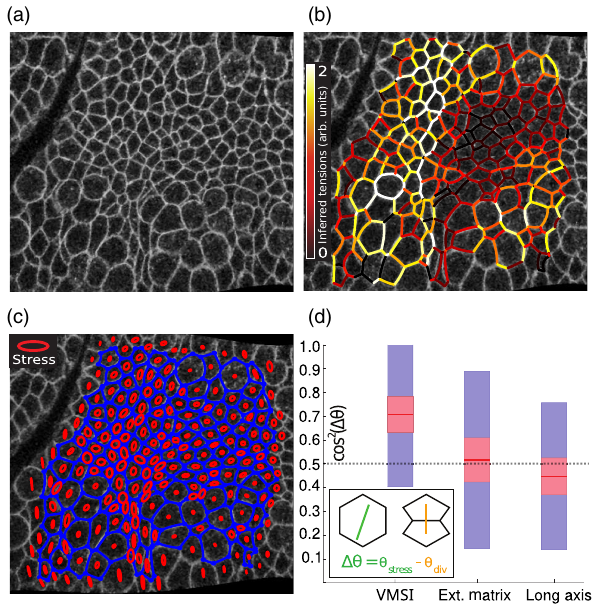
FIG. 6. Correlation of inferred stress and cell-division axis. (a) Confocal image of the Drosophila lateral ectoderm, near the cephalic furrow, during the late phase of germ-band extension (GBE) at the onset of cell divisions, approximately 45 min after the formation of the cephalic furrow. (b) An overlay of inferred tensions on the CAP array. Note that a low-tension edge (dark red) meets two high-tension edges; the latter meet at an angle close to π while low-tension edge is nearly perpendicular. (c) Same as (b) but with the average stress tensor for each cell plotted as an ellipse. The major or minor axis of the ellipse corresponds to the principal axes of stress. (d) Comparison of the cell cleavage axis for cell division events (within mitotic domains 6 and 11 [49]) and the principal (extension) axis of inferred local stress (using different methods). Stress for mitotic cells was estimated 5 min before the registered time of division. While VMSI-based analysis finds significant correlation, predictions based on the extended “ matrix inverse ” [29,35] or cell elongation axis are not distinguishable from random (shown as dashed gray